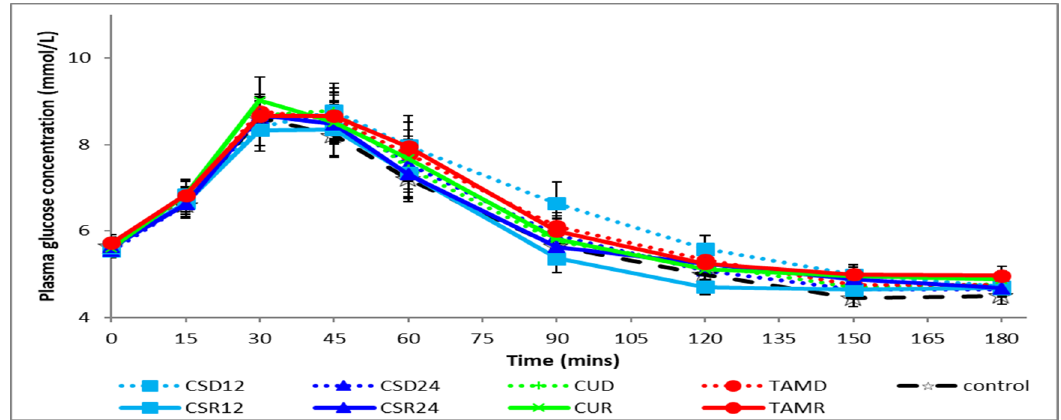
Figure 2. Postprandial changes in plasma glucose concentration during various treatments. CSD12: